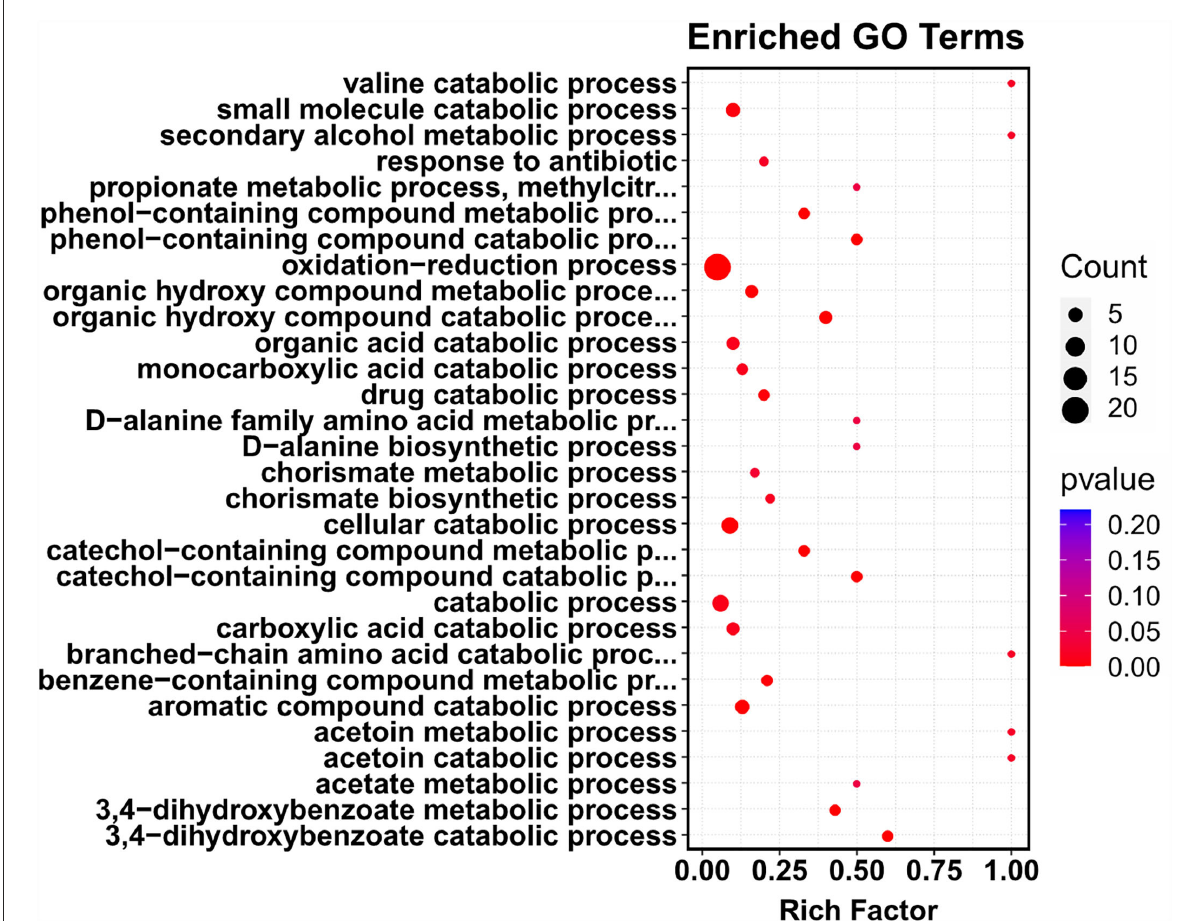
FIGURE5 Treatment of COG1410-enriched genes involved in oxidation–reduction process. The whole transcriptome analysis of A. baumannii treated or untreated with COG1410 was performed by RNA-seq. The differentially expressed genes (DEGs) were analyzed by using the edgeR (v3.16.5). Gene ontology (GO) enrichment analysis of DEGs was implemented by clusterProfiler (v3.4.4). GO terms with FDR ≤ 0.05 were considered significantly enriched by